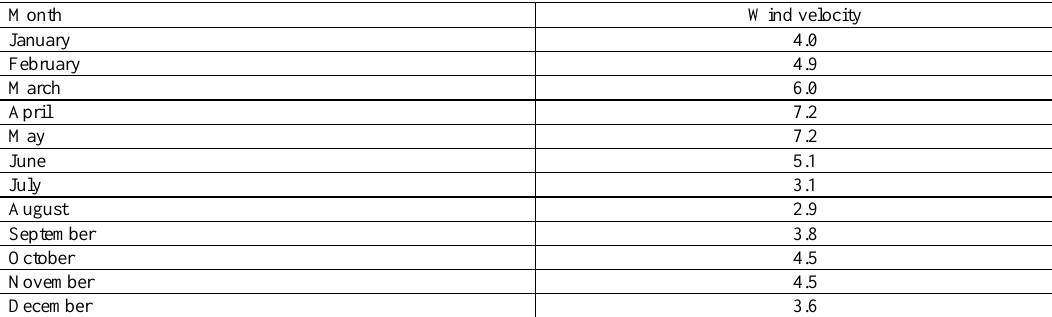
Table 2. Wind velocity in mph